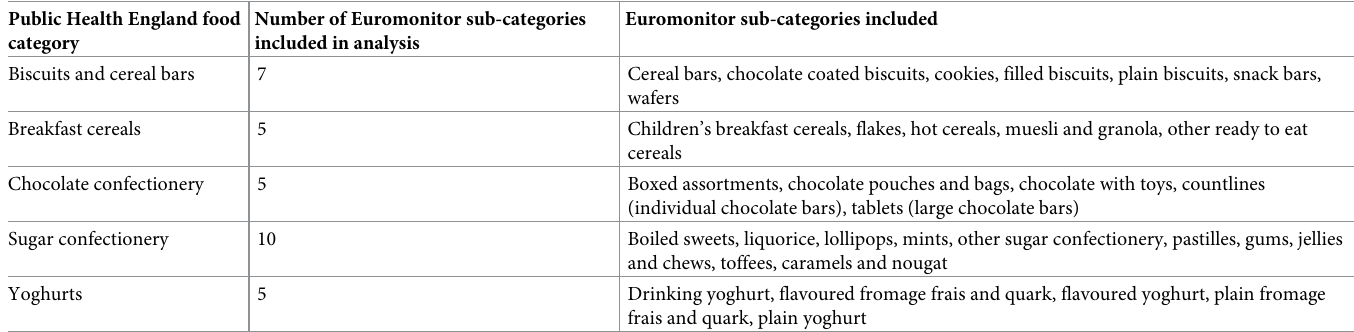
Table 1. Number and list of categories and sub-categories included in analysis. Public Health England food Number of Euromonitor sub-categories category included in